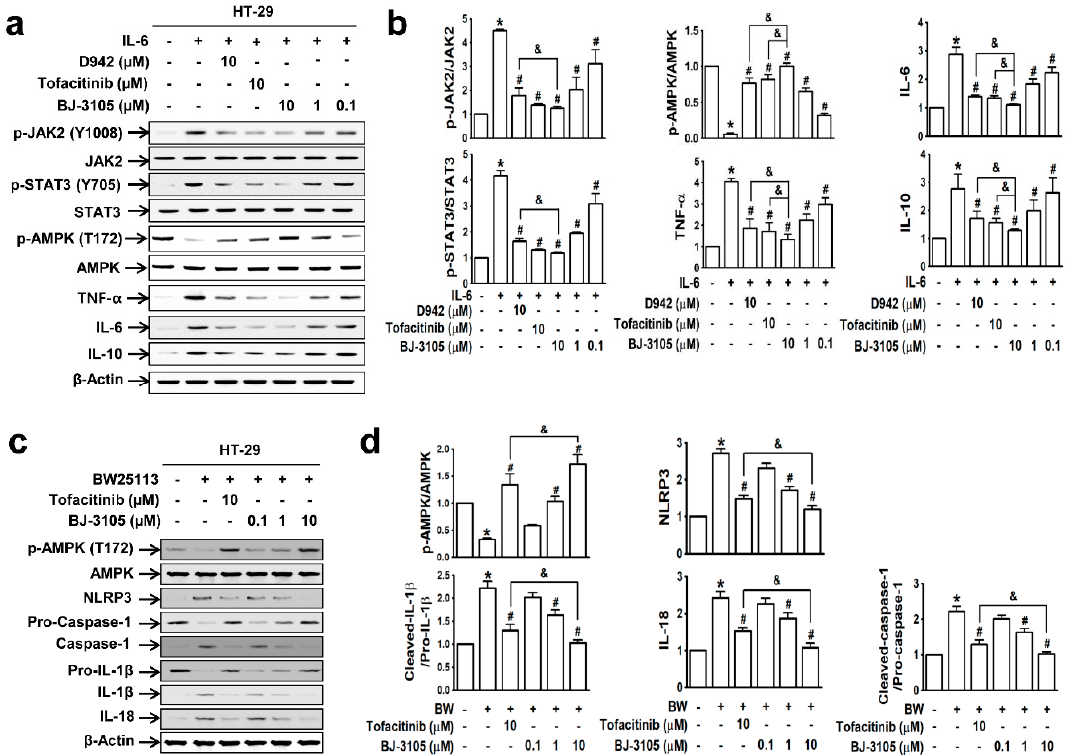
Figure 2. BJ-3105 blocked IL-6- or E. coli BW25113-induced AMPK inhibition and upregulations of cytokines and inflammasome better than tofacitinib in HT-29 cells. ( a , b ) Immunoblots ( a ) and quantitation ( b ) of IL-6-induced phosphorylation of JAK, STAT, and AMPK, and expressions of inflammatory cytokines. * p < 0.05, versus the vehicle-treated control group. # p < 0.05, versus the IL-6-treated group. & p < 0.05, versus the tofacitinib-treated group. ( c , d ) HT-29 cells were prereated with BJ-3105 or tofacitinib for 1 h prior to commensal bacteria ( E. coli strain BW25113) for 3 h. After HT-29 cells were washed three times with PBS to remove non-adhering E. coli , the cells were used for immunoblotting. Immunoblots ( c ) of AMPK and inflammasome components, and their quantitation ( d ). Results are presented as the means ± SEMs of at least three independent experiments. * p < 0.05, versus the vehicle-treated control group. # p < 0.05, versus the BW25113-treated group. & p < 0.05, versus the tofacitinib-treated group.